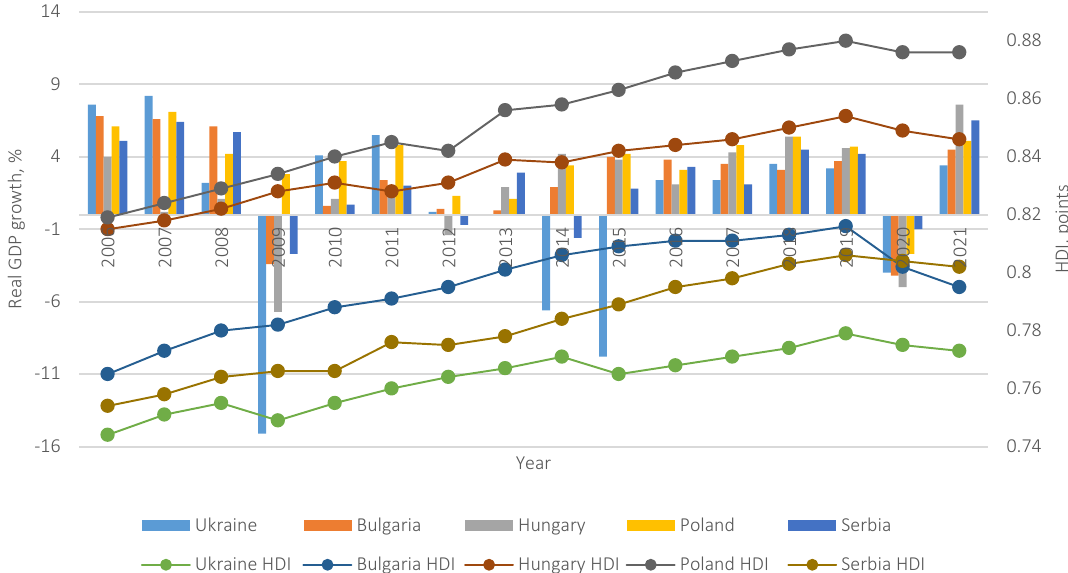
Figure 1. Real GDP growth in % for Ukraine, Bulgaria, Hungary, Poland, Serbia and Human